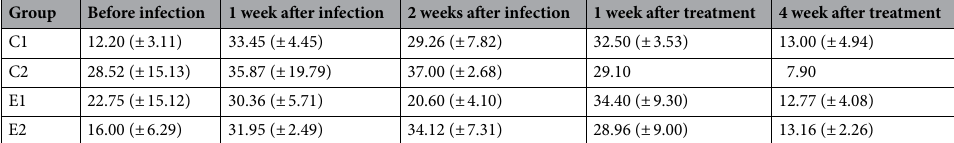
Table 3. The change of the Neutrophil percentage. The changes are depicted as mean ± standard deviation (SD).